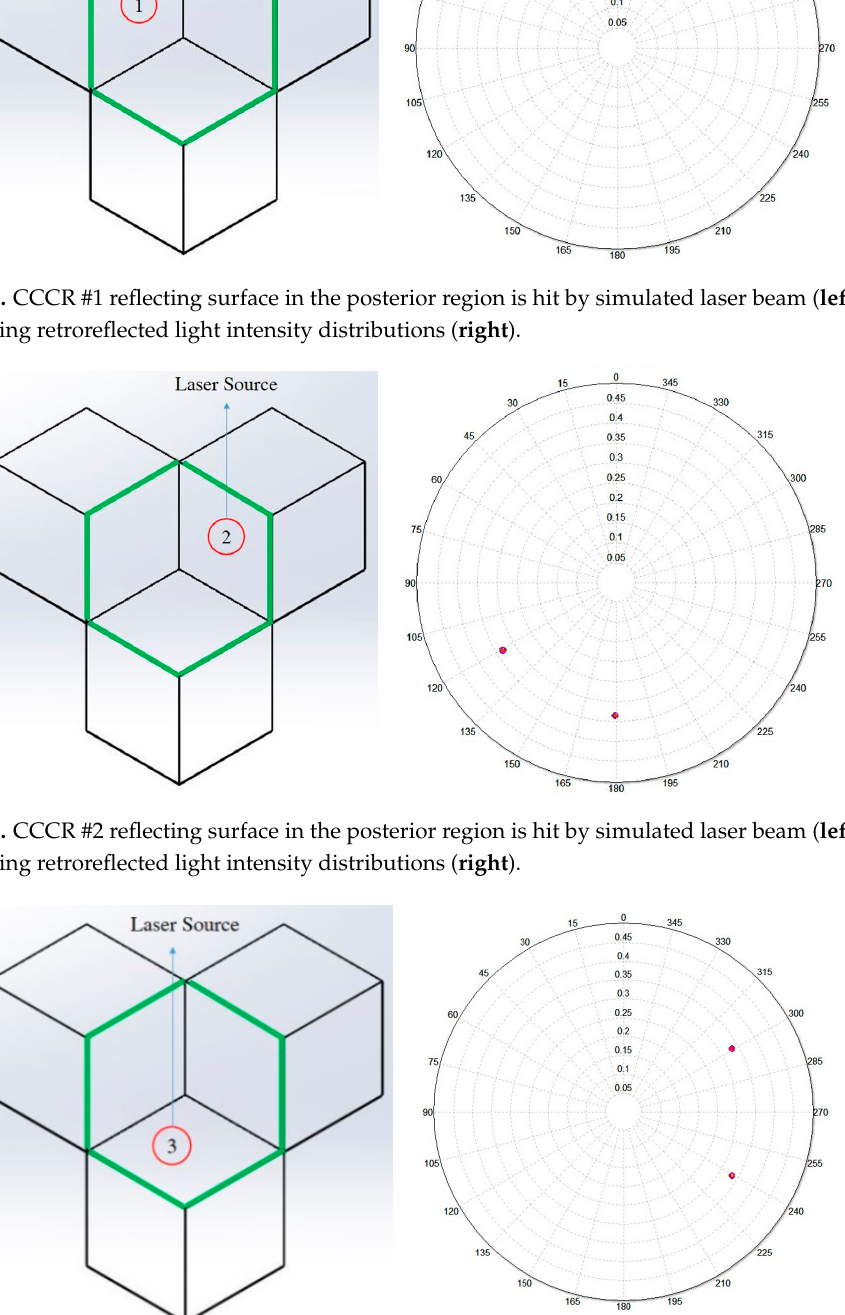
Figure 15. CCCR #3 reflecting surface in the posterior region is hit by simulated laser beam ( left ) and the resulting retroreflected light intensity distributions ( right ).